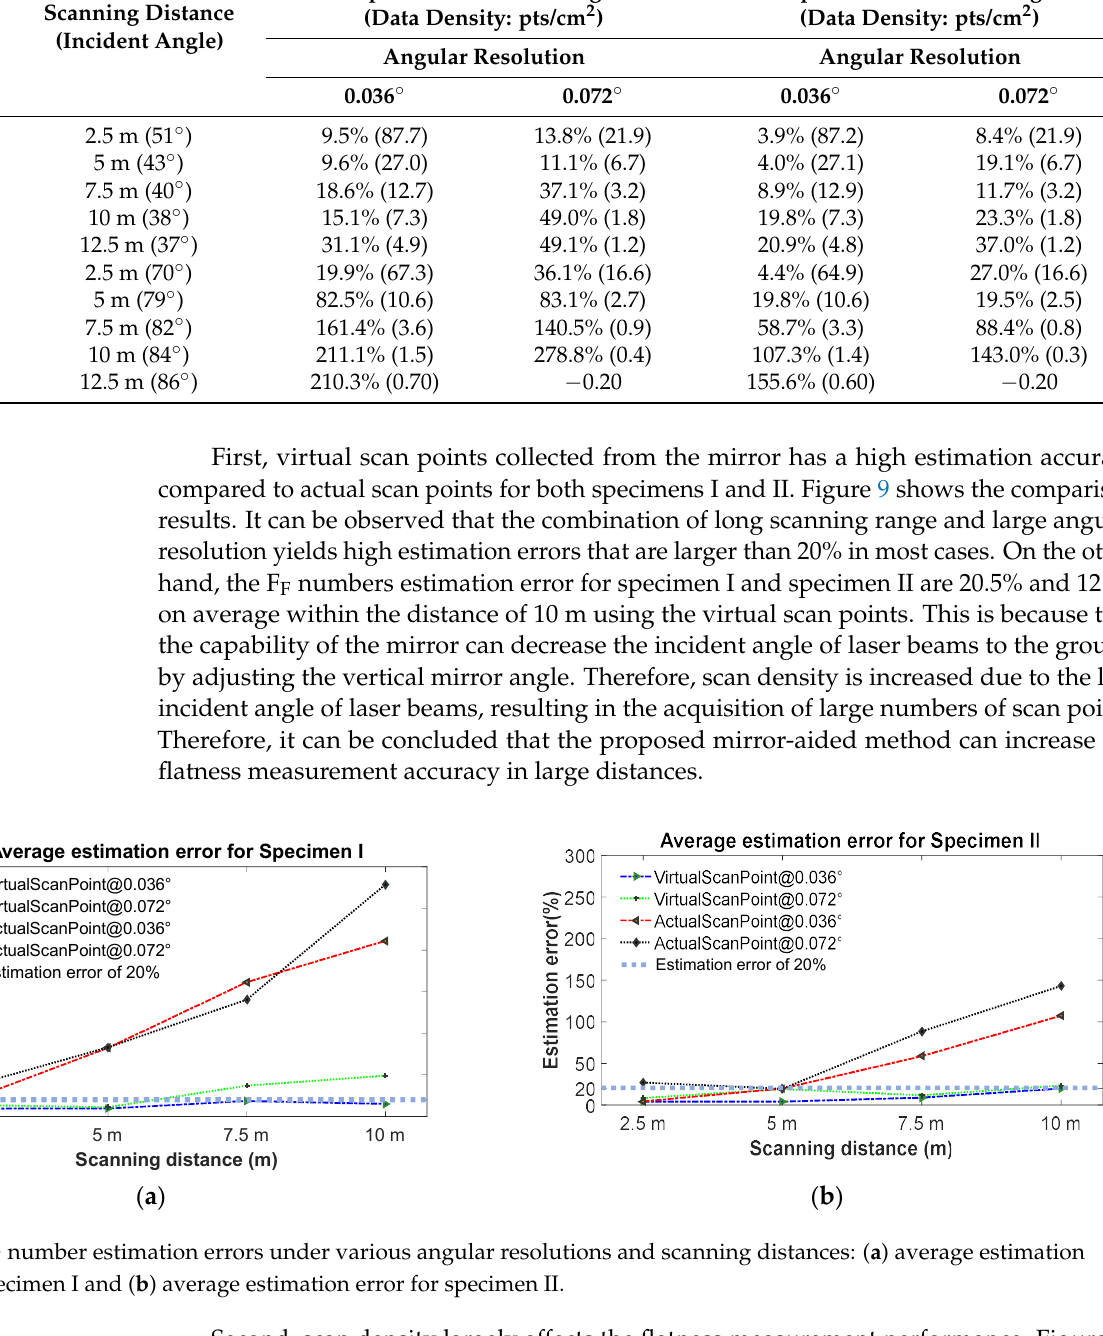
Table 3. Estimation errors for F F numbers under varying angular resolutions and scanning distances.